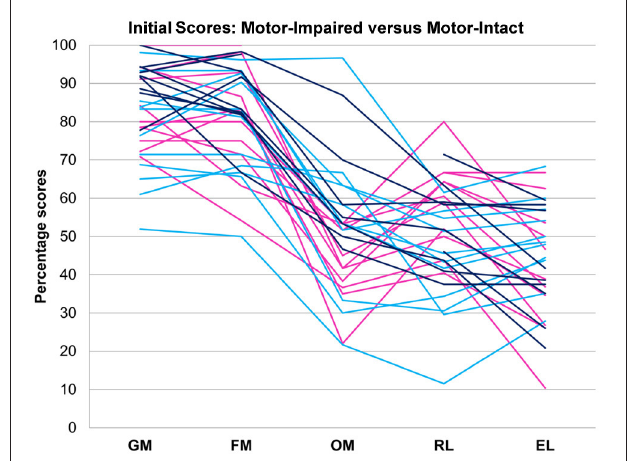
FIGURE 1 | Motor-impaired (magenta) and motor-intact (blue, with receptive-impaired subgroup in light blue and receptive-intact subgroup in dark blue) groups. The discriminant between motor-impaired and motor-intact groups − 0 . 28 · OM − 0.15 · GM + 0.55 · RL − 0.20 · EL loaded heavily on the receptive-expressive difference and on oral motor skills, and also slightly on gross motor skills. GM, gross motor; FM, fine motor; OM, oral motor; RL, receptive language; EL, expressive